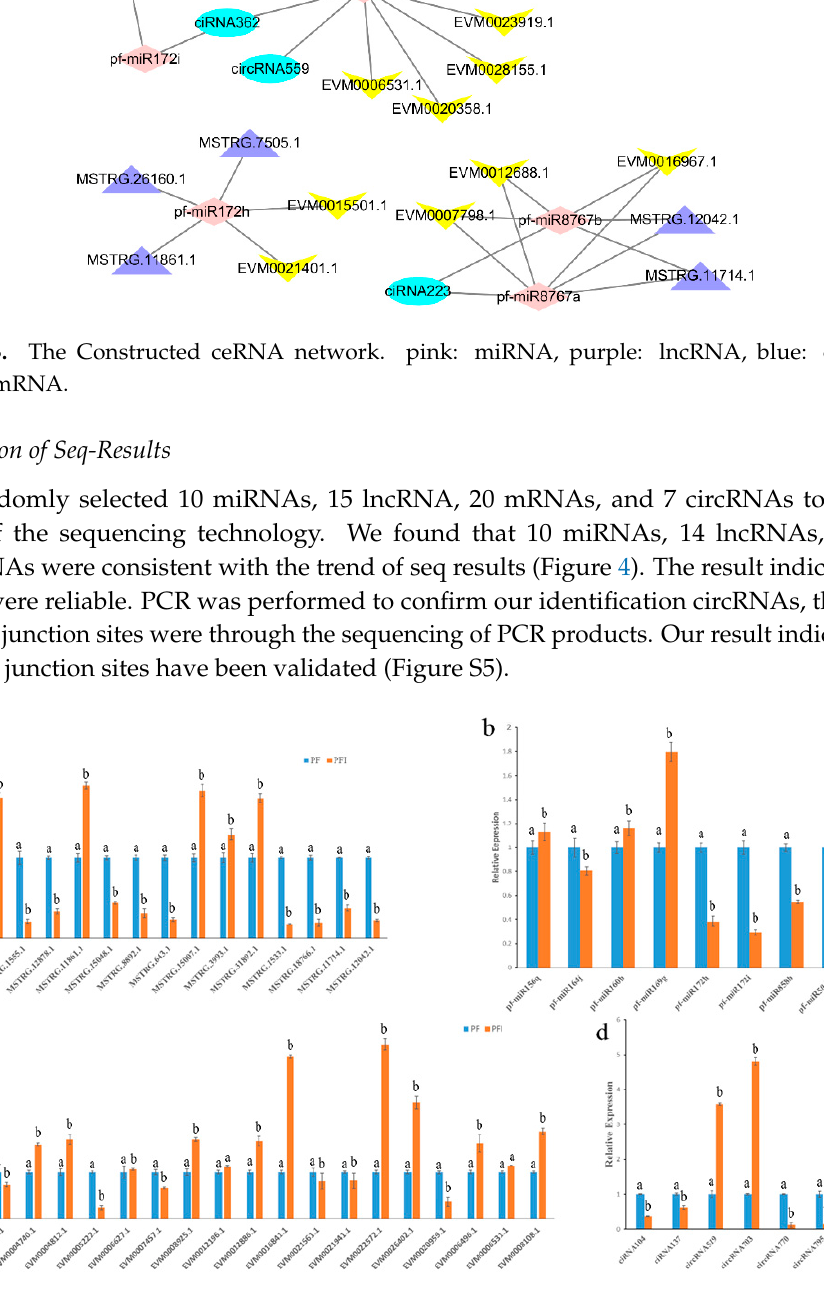
Figure 4. Quantitative Real-Time PCR (qRT-PCR) analysis. ( a ) Relative expression levels of miRNAs; U6 snRNA was used as the endogenous reference gene. ( b ) Relative expression levels of lncRNAs; 18S rRNA was used as the endogenous reference gene. ( c ) Relative expression levels of mRNAs. ( d ) Relative expression levels of circRNAs; 18S rRNA was used as the endogenous reference gene. The standard error of the mean for three replicates is represented by the error bars. Samples marked with various letters show a significant difference at p < 0.05.